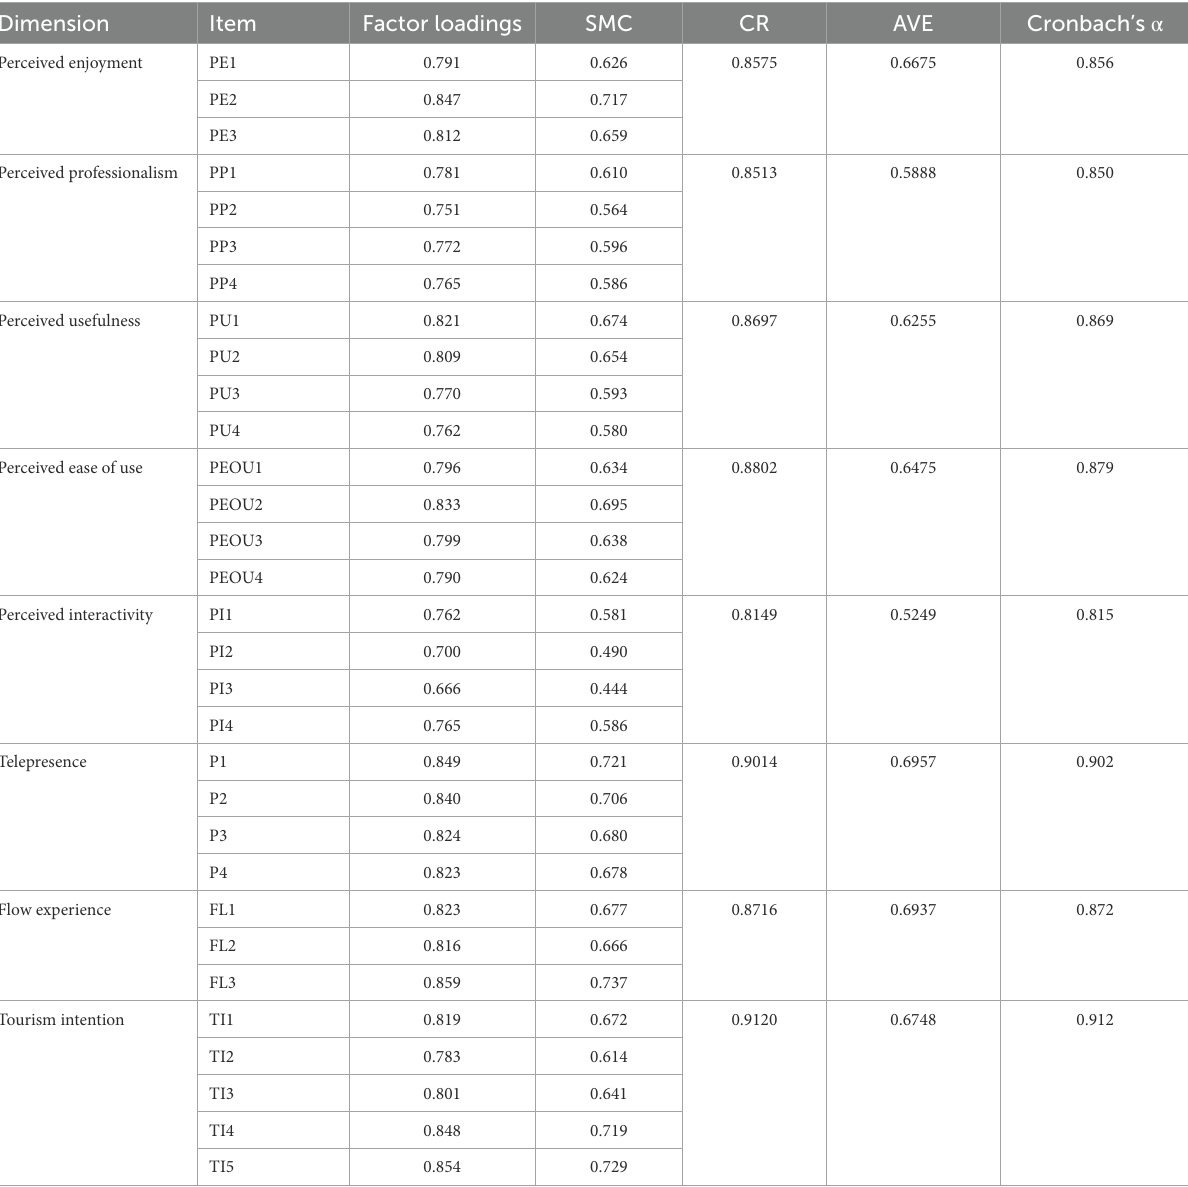
TABLE 2 Reliability and validity analysis results of questionnaire.